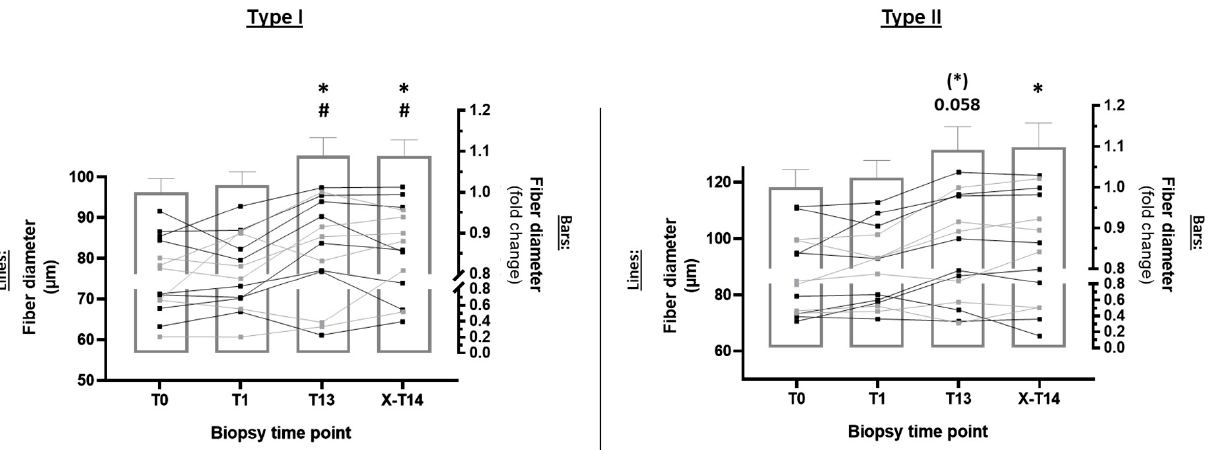
Figure 3. Determination of myofiber hypertrophy via analysis of type I and type II fiber diameter. Bar graphs display the mean ± standard error of the mean. The right x -axis represents the fold change in fiber diameter (T1, T13, and X-T14 compared to T0). Normalization to the baseline (T0) was performed by dividing all time points of individual subjects by the total average of T0. Lines (left x -axis) represent the absolute change in an individual subject’s fiber diameter (µm). Differently colored lines in the diagram represent subjects from CO (gray dots and lines) and PR (black dots and lines). * p < 0.05 with respect to T0; # p < 0.05 with respect to T1.